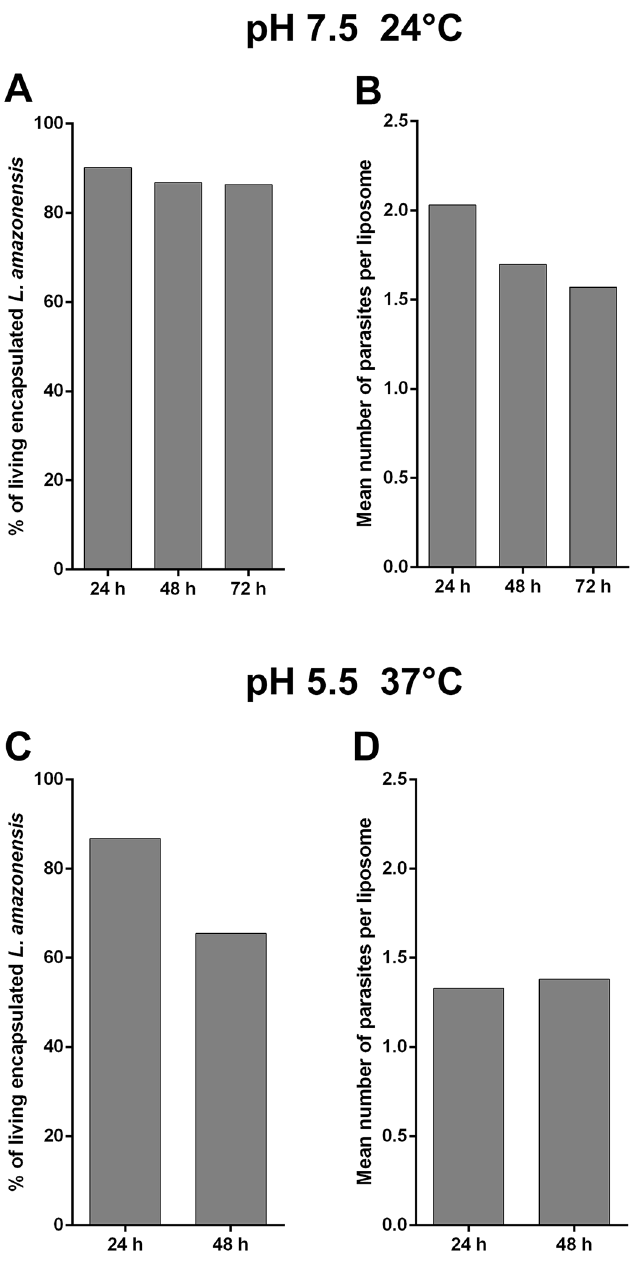
Fig 5. L . amazonensis viability in liposomes. Parasites in RPMI-dextran were encapsulated in liposomes and the living parasites were counted as function of time. (A) Average percentage of living encapsulated parasites. (B) Average number of living parasites per liposome after 24, 48 and 72h at pH 7.5 at 24°C. (C,D) Same parameters as in A and B after 24 and 48h at pH 5.5 at 37°C.